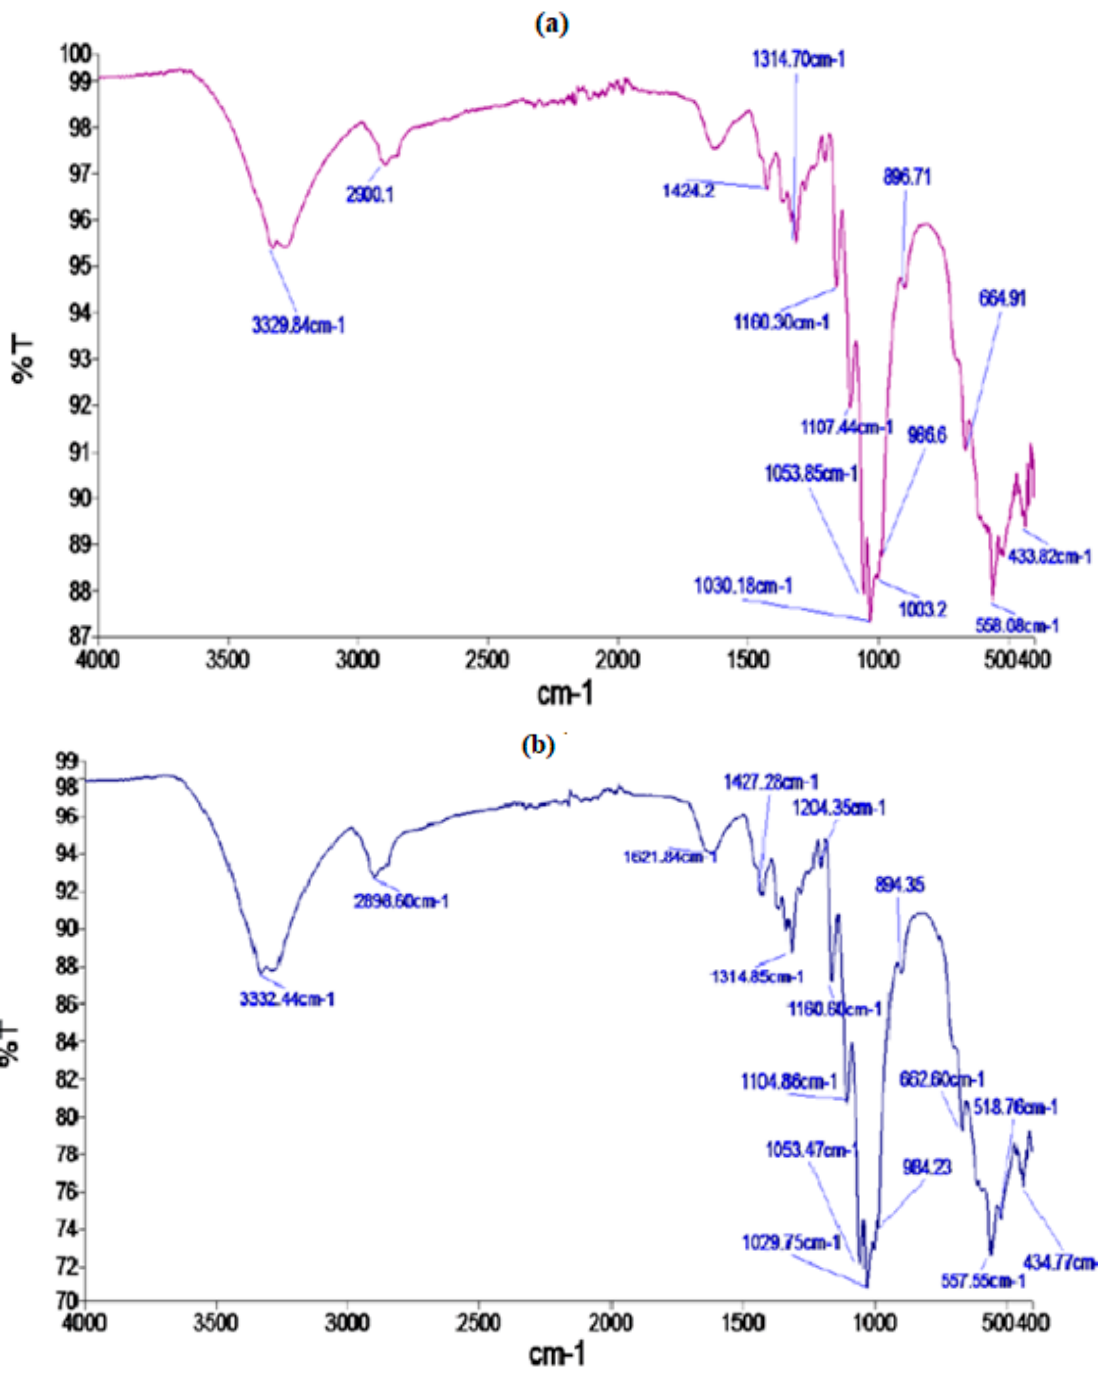
Figure 3. FTIR spectra of control ( a ) and microwave treated ( b ) cotton fabric.